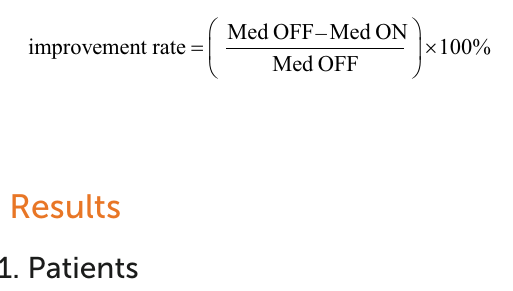
Table 1. There was no significance difference in average signal duration between groups (EOPD: 229.39 ± 106.10 s, LOPD: 188.04 ± 125.29 s, p = 0.16).